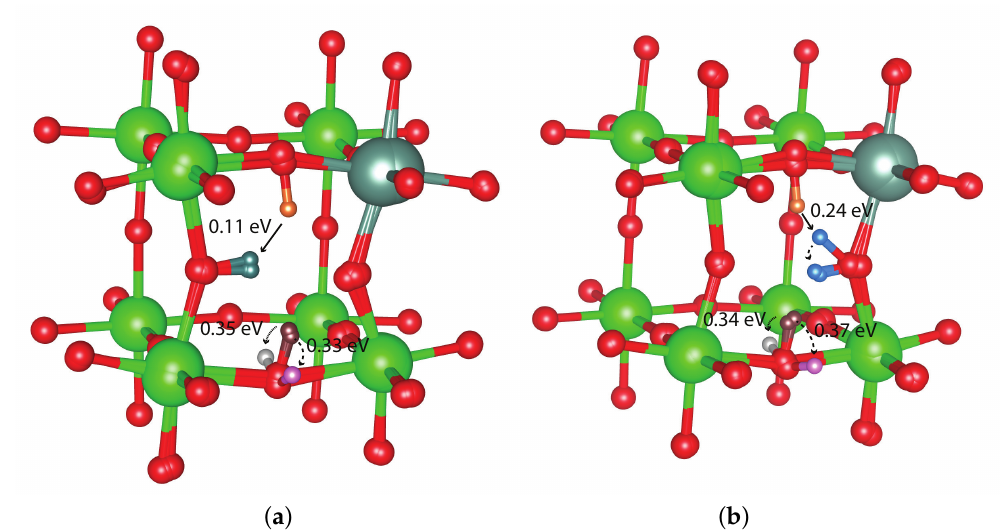
Figure 3. The sequential move most critical to escape one dopant trap is a transfer followed by a rota- tion and can occur in two ways shown in ( a , b ). In each case, the first transfer move is highlighted with a solid arrow, and the second two possible rotations are marked by short- and long-dashed arrows. Table 2. Barriers are affected by nearby protons. This table summarizes the barrier for the motions in Figure 1 with different protons present. In addition, single proton movement barriers in the same size system [10,21] and a smaller system [15] are shown for